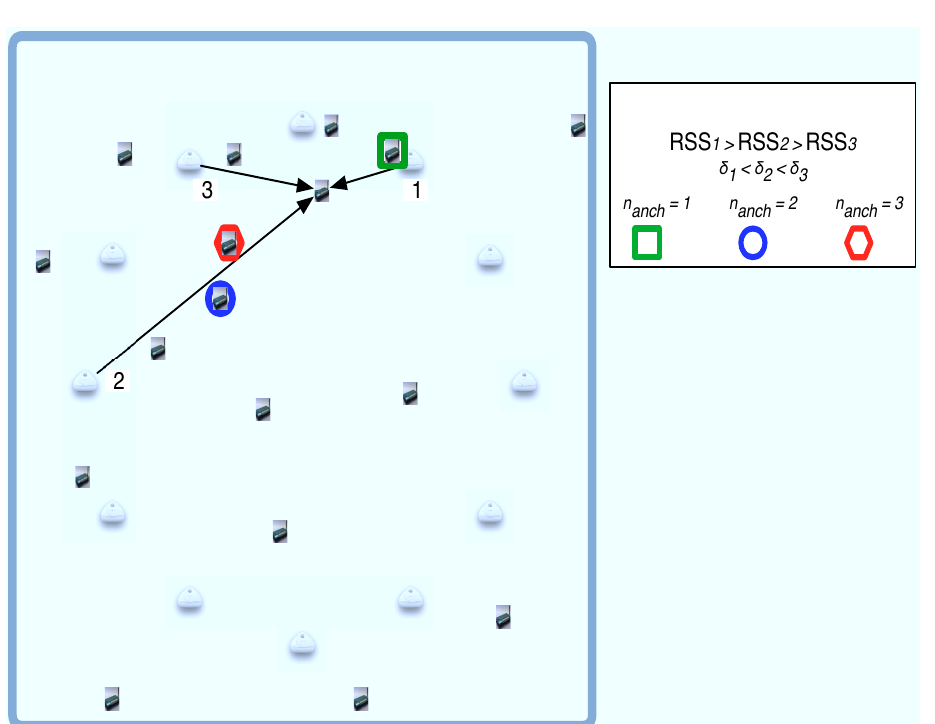
Figure 2. Example of an initial position with different values of n anch .